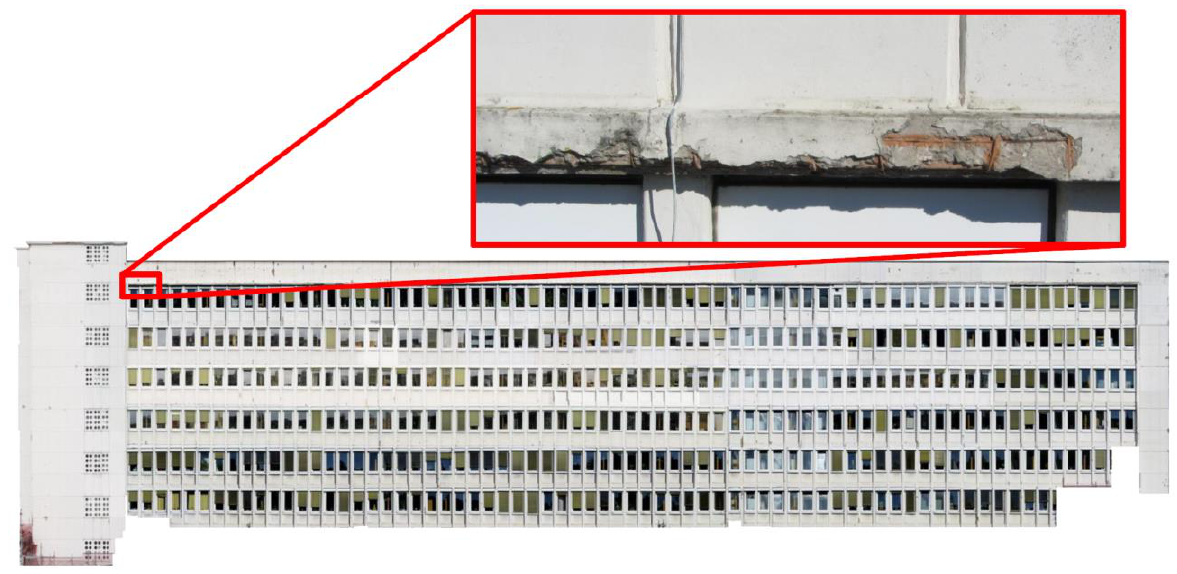
Figure 4. Ultra-high resolution digital façade reconstruction based on several hundred